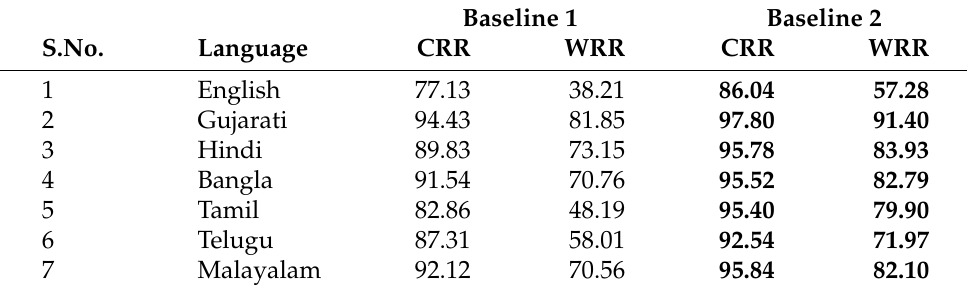
Table 2. Results of individual baselines on synthetic datasets.